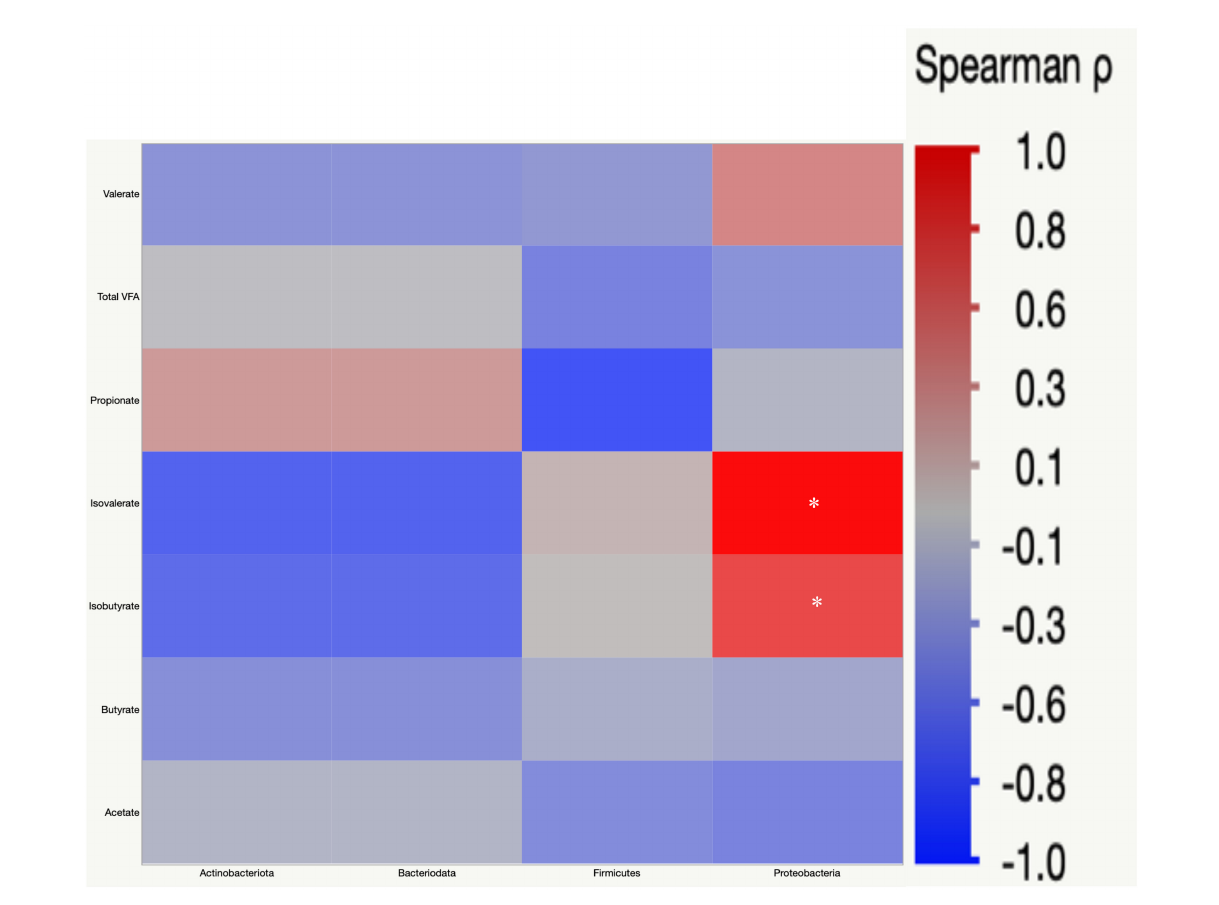
FIGURE9 Spearman’s rank correlation matrix of the four main phyla and short chain fatty acids (SCFA). The colors of the scale bar denote the nature of the correlation with one indicating a perfect positive correlation (dark red) and –1 indicating perfect negative correlation (dark blue). Significant correlations are indicated by asterisk (* P <